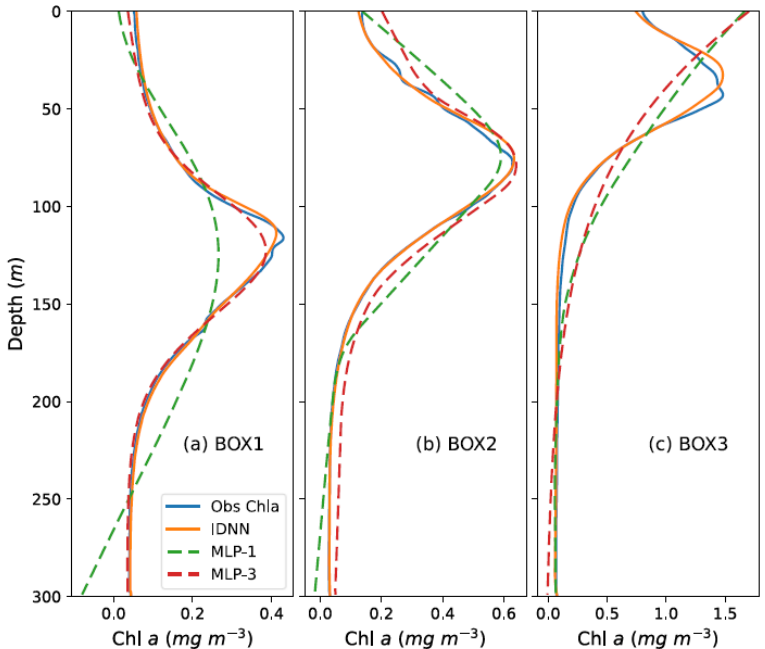
Figure 9. Modeling Chl a profiles by the IDNN and MLP models in three BOXes ( a – c ) of the northwestern Pacific Ocean. The configuration of MLP-1 is 6-10-1, that is, 6 input variables, 10 hidden nodes, and 1 output. The MLP-3 model is 6-3*64-1, that is, 3 hidden layers and 64 nodes in each hidden layer.